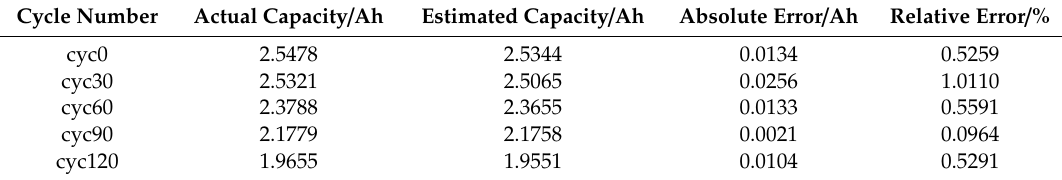
Table 4. The estimated results and errors of the battery during the entire lifespan.